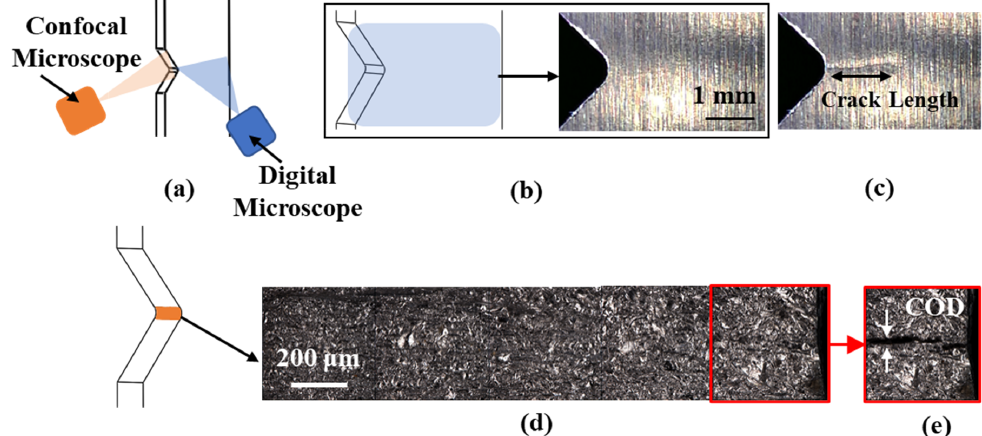
Figure 5. ( a ) A schematic of the specimen illustrating the viewing areas of the digital and confocal microscopes; ( b ) A typical image area captured by the digital microscope and the corresponding image of a representative specimen; ( c ) A cracked version of the specimen as captured by the digital microscope indicating the crack length; ( d ) The region of interest of the confocal microscope with a collage of six individual images covering the entire notch root of a representative spec- imen; ( e ) An image of the 6th segment (extreme right of ( d )) of the collage showing the formation of a fatigue crack de- picting the